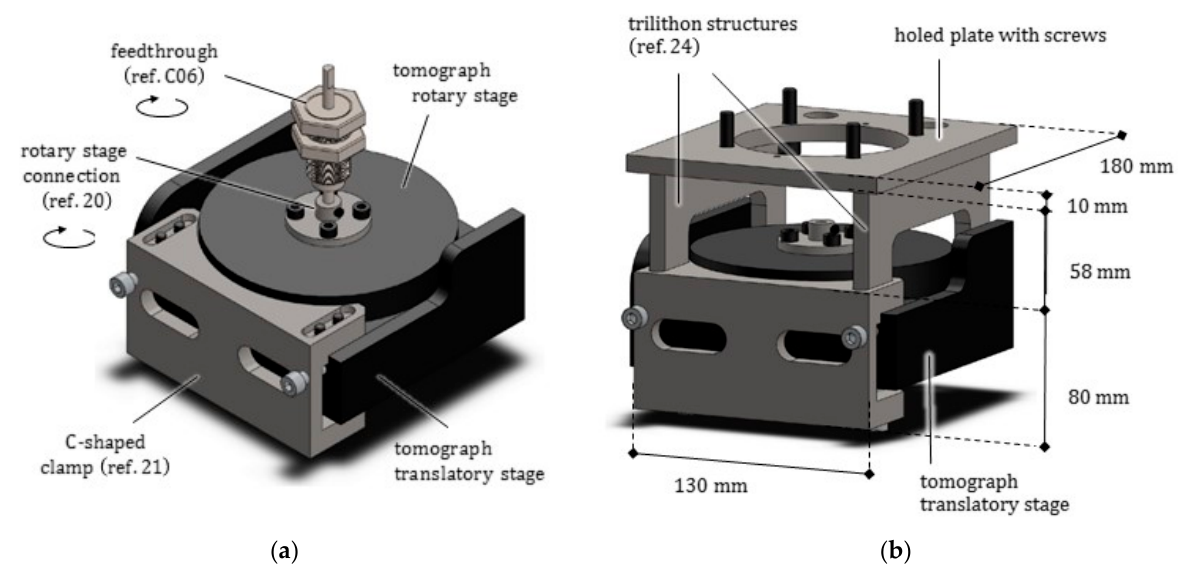
Figure 8. ( a ) View of the feedthrough inserted into the head of a connection component (ref. 20 ), in turn screwed to the rotary plate of the tomograph. ( b ) Anchoring system of the furnace, composed of C-shaped clamp (ref. 21 ), two lateral trilithon structures (ref. 24 ), and a thick holed plate permitting the passage of the connection component (ref. 20 ) and wires.